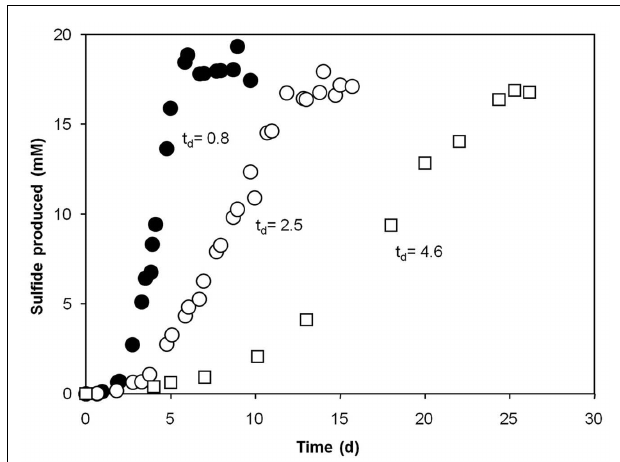
FIGURE 3 | Comparison of heterotrophic and autotrophic growth of Desulfovibrio indonesiensis strain P23 at 35˚C ( (cid:2) ) under autotrophic conditions using hydrogen, CO 2 and sulfate (28mM); ( of 1mM acetate, both in the presence of resazurin and vitamins; ( (cid:2) ) under autotrophic conditions in media without vitamins and resazurin. Doubling times ( t d ) in days are